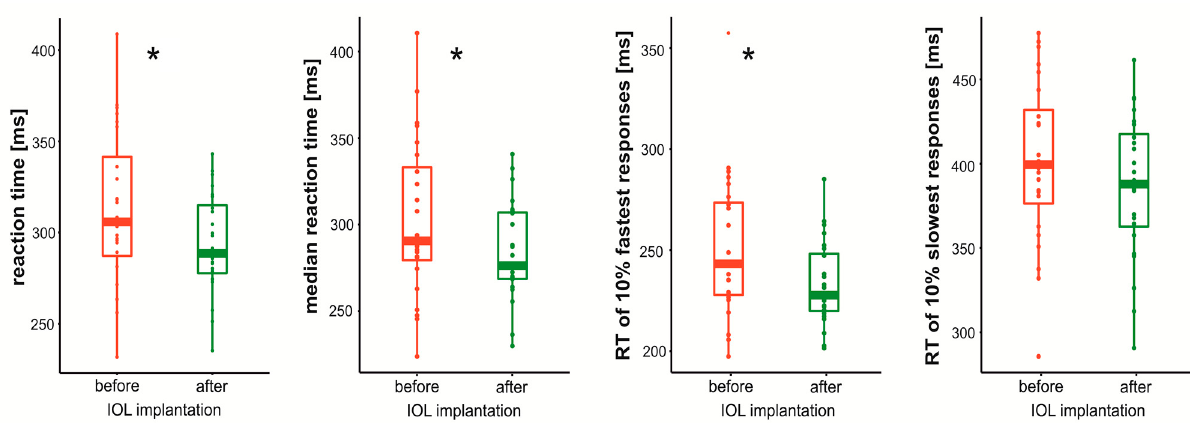
Figure 1. Boxplot showing reaction time distribution before and after Intraocular lens implantation. * Indicate significant difference between sessions